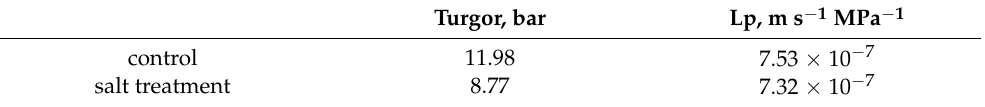
Figure 4. Immunohistochemical localization of ABA in the leaves of the control ( A ), salt- ( B ), and Table 1. Turgor and hydraulic conductivity (Lp) of ridge cells overlying large lateral ABA-treated ( C ) barley plants. 1—vasculature, 2—mesophyll, 3—stomata, 4—chlorophyll. Scale 100 µm.